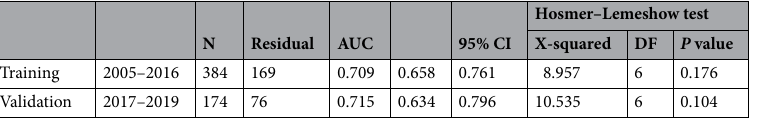
Table 4. Discrimination and Calibration ability of the developed nomogram. AUC = C statistics. Optimism corrected C statistics by 1000 bootstrap resamples.